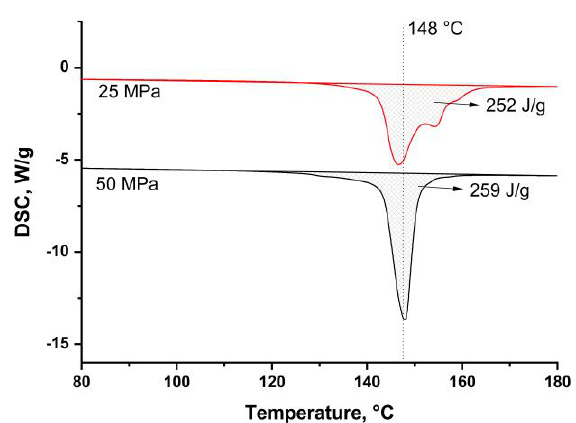
Figure 7. DSC analysis of the samples obtained at 165 ◦ C and pressure of 25 MPa (red curve) and 50 MPa (black curve).